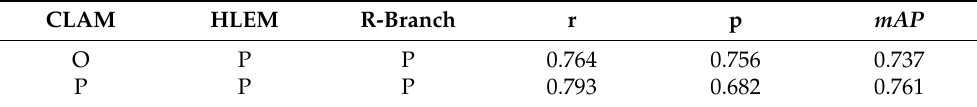
Table 9. Effectiveness of CLAM when the other two modules are added.